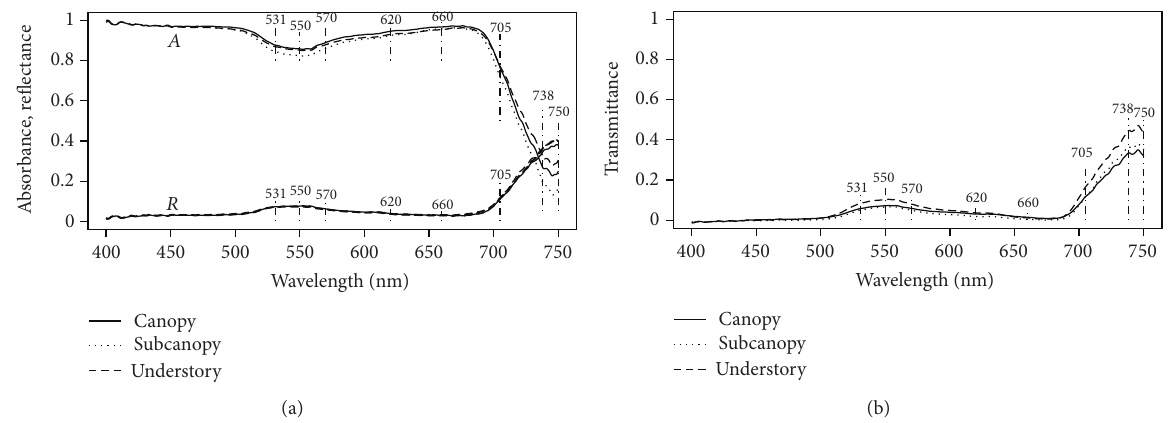
) and Re�ectance ( ). 𝐴𝐴 𝑅𝑅